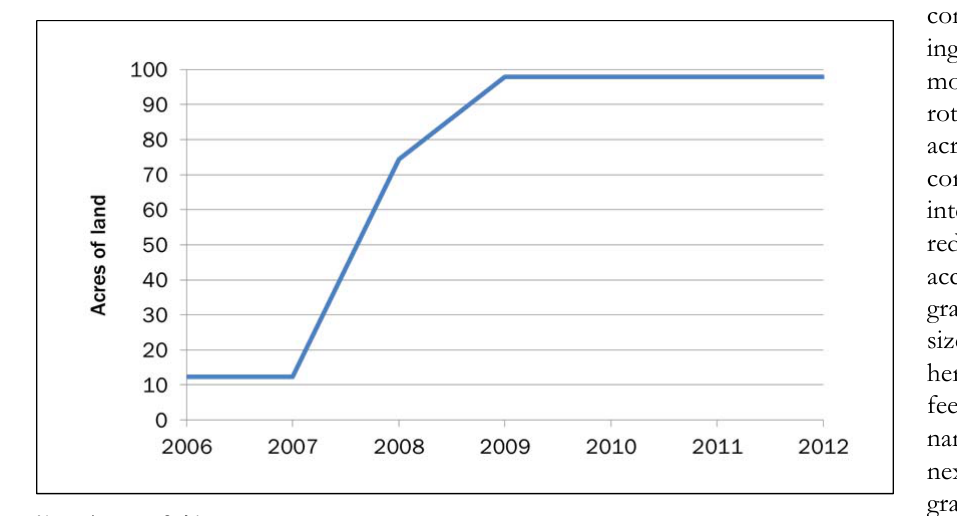
Figure 2. Acreage of Land Managed Organically of the 412 Available Acres of the Berea College Student Farm, 2006–2012